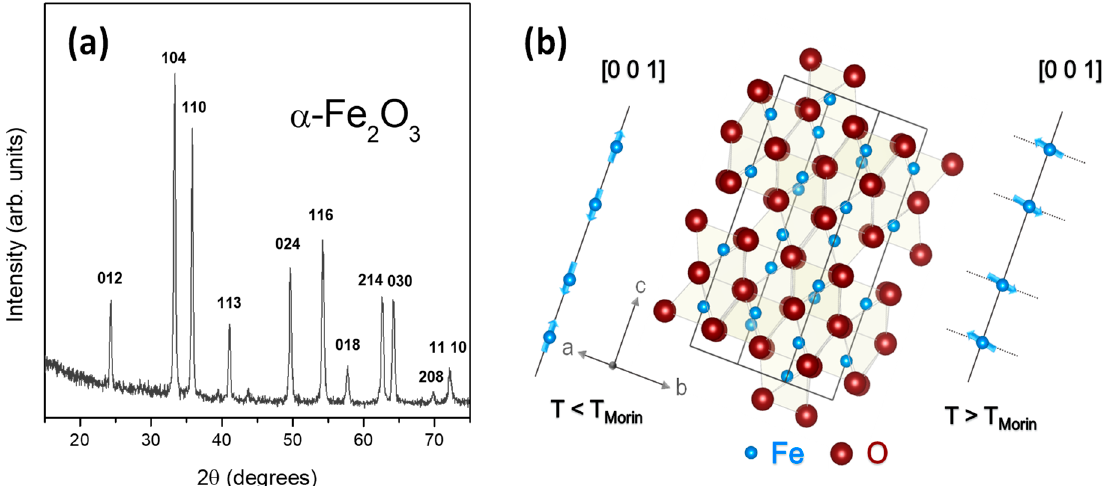
Figure 1. ( a ) Crystal structure representation of hematite employing the VESTA software. A schematic spin moment visualization of the atoms along [0 0 1] are shown below and above the Morin transition for inspection. ( b ) XRD pattern of single-phase nanoparticulated hematite coating obtained from a Fe film annealed at 1050 ° C on a silica substrate. Main reflection planes are indicated at the maxima accordingly [10].